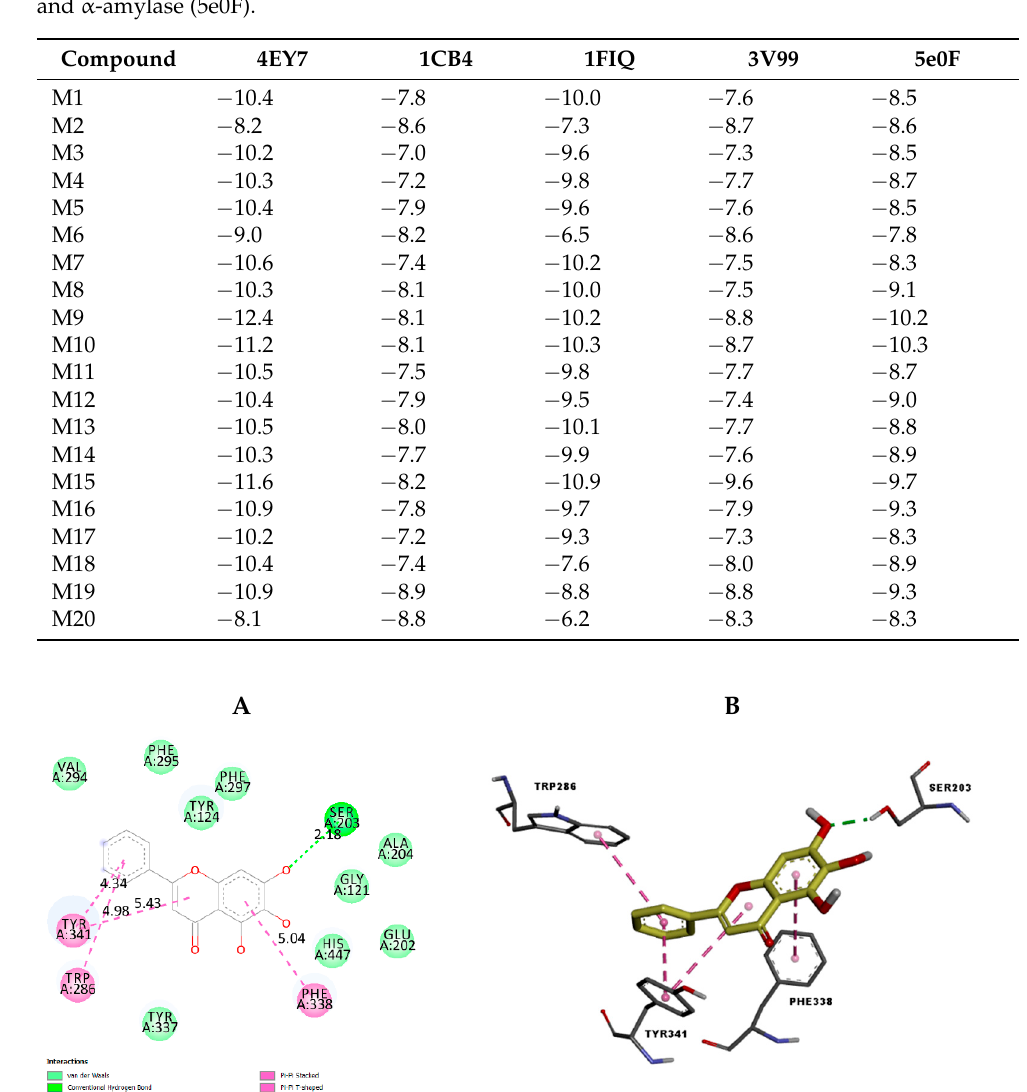
Figure 4. The 2D ( A ) view and 3D ( B ) view of the interaction type of M7 with the surrounding amino acids of superoxide dismutase. 2.56